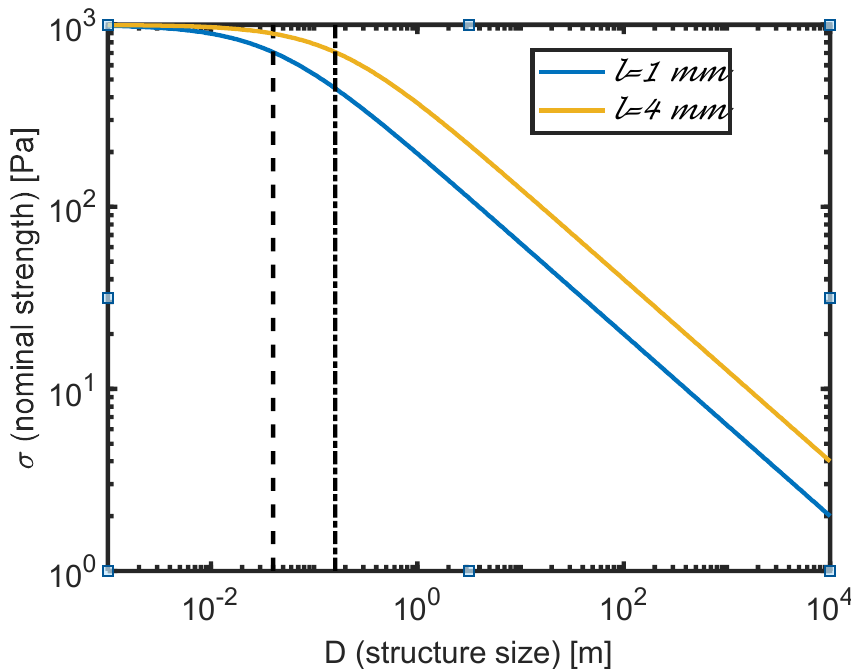
Figure 4. Size effect law [31] for quasi-brittle failures bridging the power law of plasticity (horizontal asymptote) and the power law of LEFM (inclined asymptote). The small-size asymptotic strength (compressive or tensile) has been arbitrarily set to 1000 Pa and l to 1 mm (blue curve) or 4 mm (yellow curve). These values could be roughly appropriate for the cometary material at 67P’s Abydos site (see main text). The corresponding values of D 0 , 40 mm and 160 mm, are indicated as vertical black dashed and dash-dotted lines, respectively.